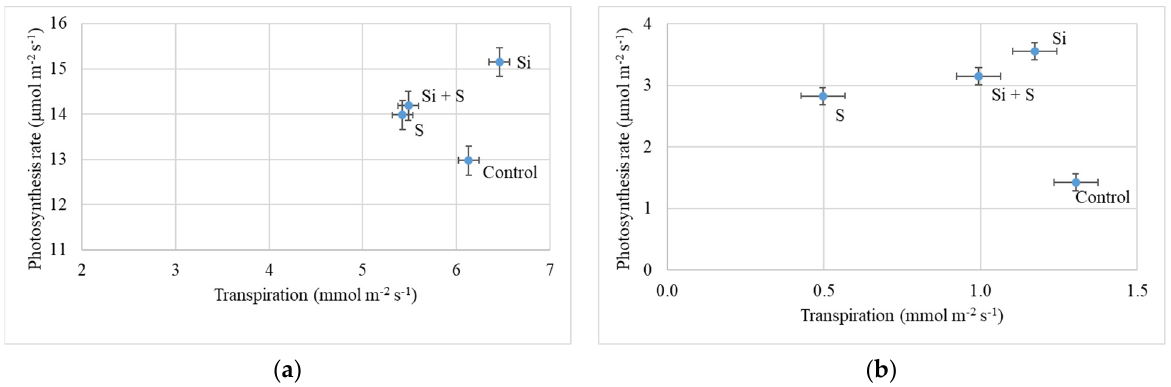
Figure 6. ( a ) Photosynthesis rate of oat as a function of transpiration (27 May, BBCH52); ( b ) Photosynthesis rate of oat in the function of transpiration (24 June, BBCH77). Means of the varieties, ± standard error.